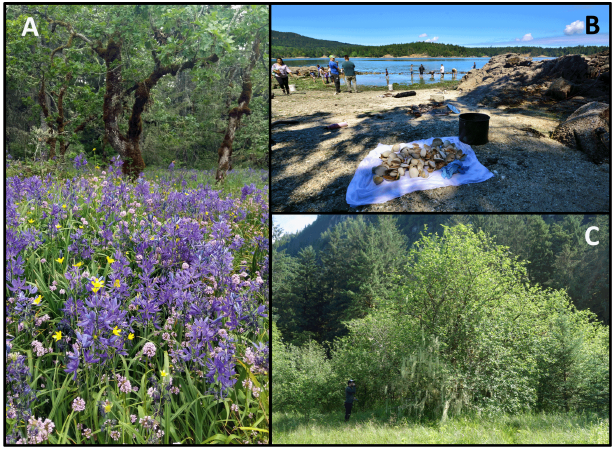
Fig. 1. Examples of ecosystems associated with Indigenous management: (A) Cowichan Garry Oak Preserve in WSÁNE Ć territory, South Vancouver Island, British Columbia (BC; photo courtesy Kelly Fretwell), (B) clam gardens in WSÁNE Ć territory, Gulf Islands National Park Reserve, BC (photo courtesy Iain Robert Reid), (C) crabapple orchard in Wuikinuxv territories, Central Coast,